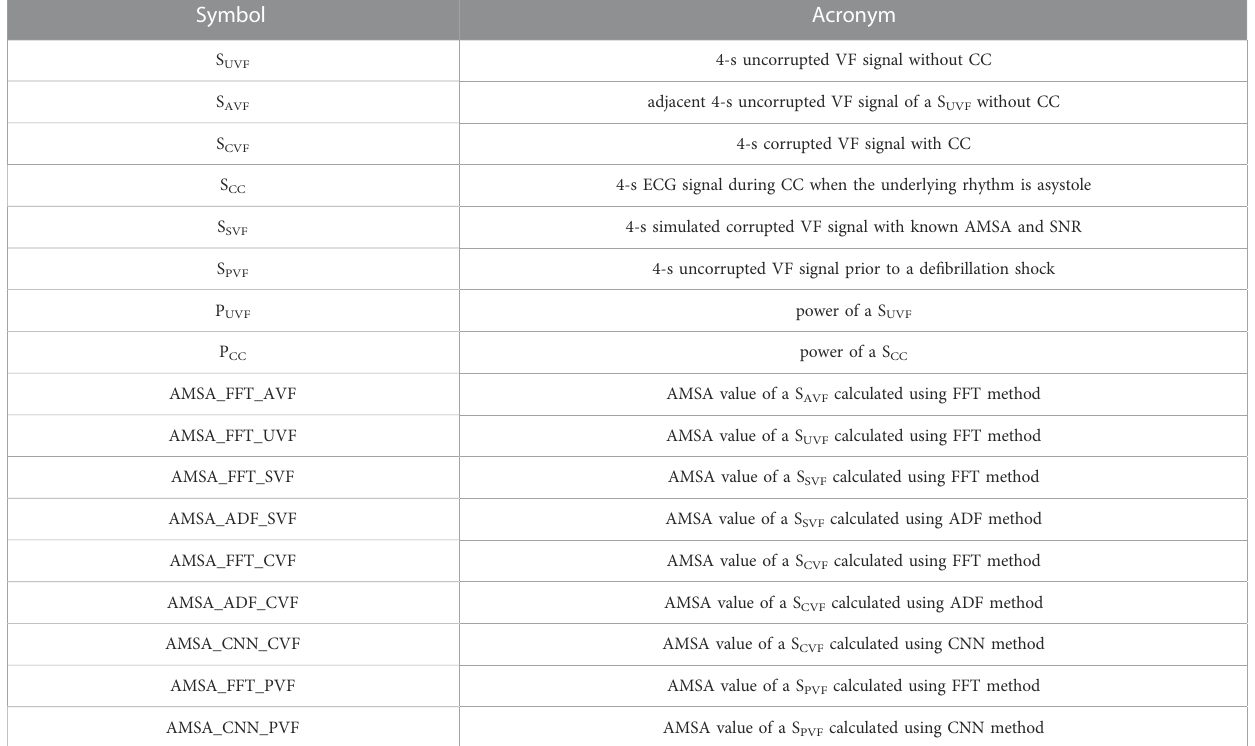
TABLE 1 symbols and acronyms used in the current